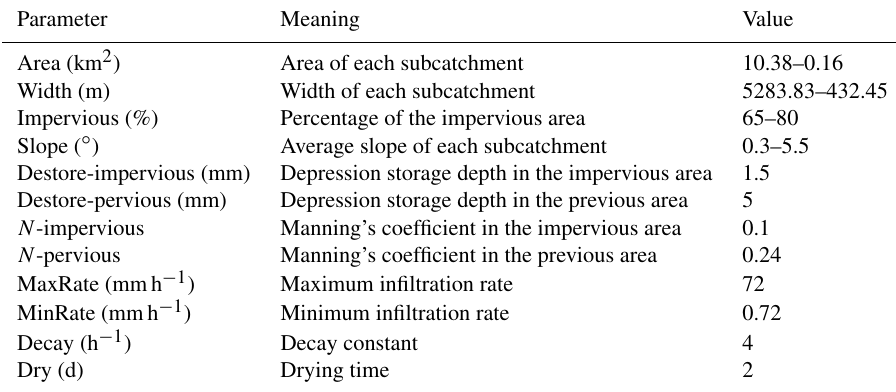
Table 1. Parameters of the subcatchments in the